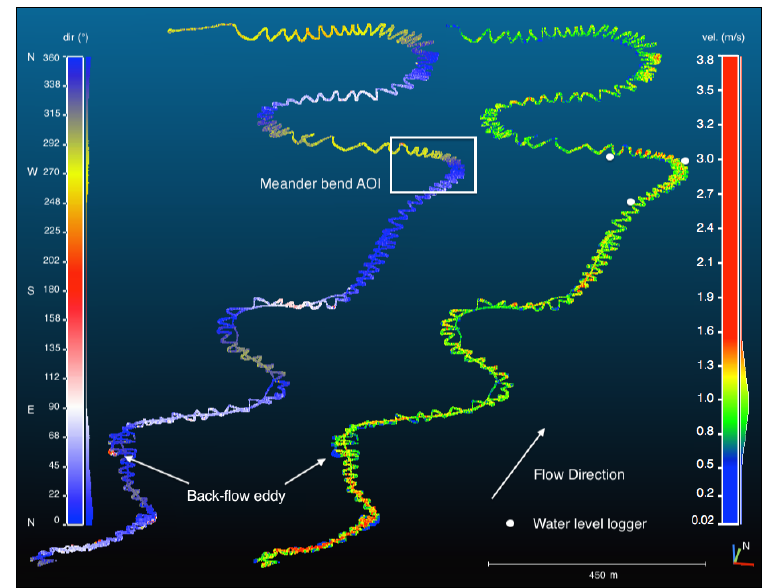
Figure 5. Point cloud of raw measured flow data of the whole study reach (3.7 km) on 18 May 2013 looking downstream. The left-hand plot shows flow directions in degrees from the north and the right-hand plot shows flow velocities in m/s. A back-flow eddy location is clearly detectable in the plot of flow directions. The location of the meander bend AOI is indicated by a box, and the approximate locations of the water level loggers are indicated by three points. The actual water level loggers were located about 2 m from the shore at low water, but for ease of visualization, approximate locations are shown